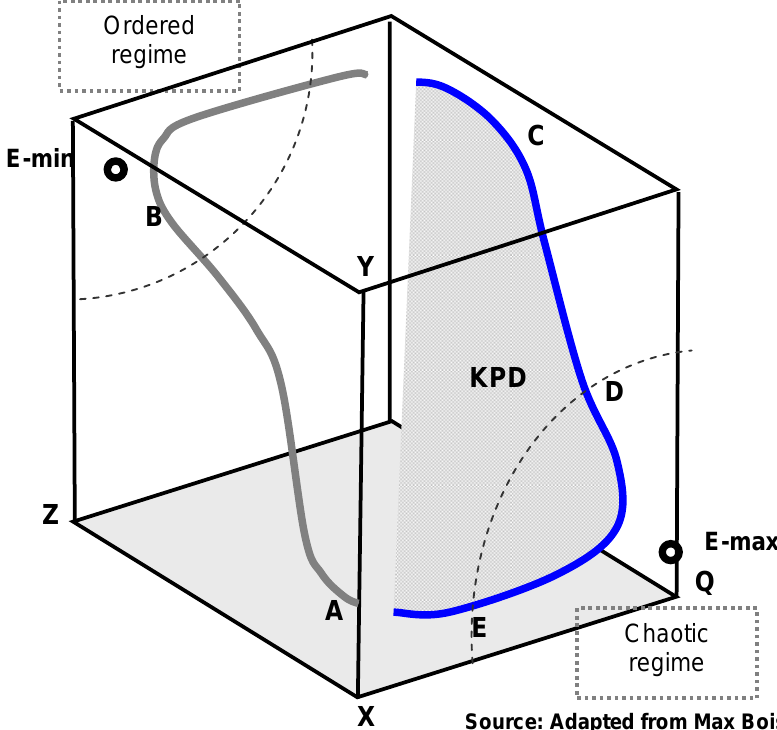
Figure 3: Knowledge Prospect Domain (KPD) in Boisot’s I-Space